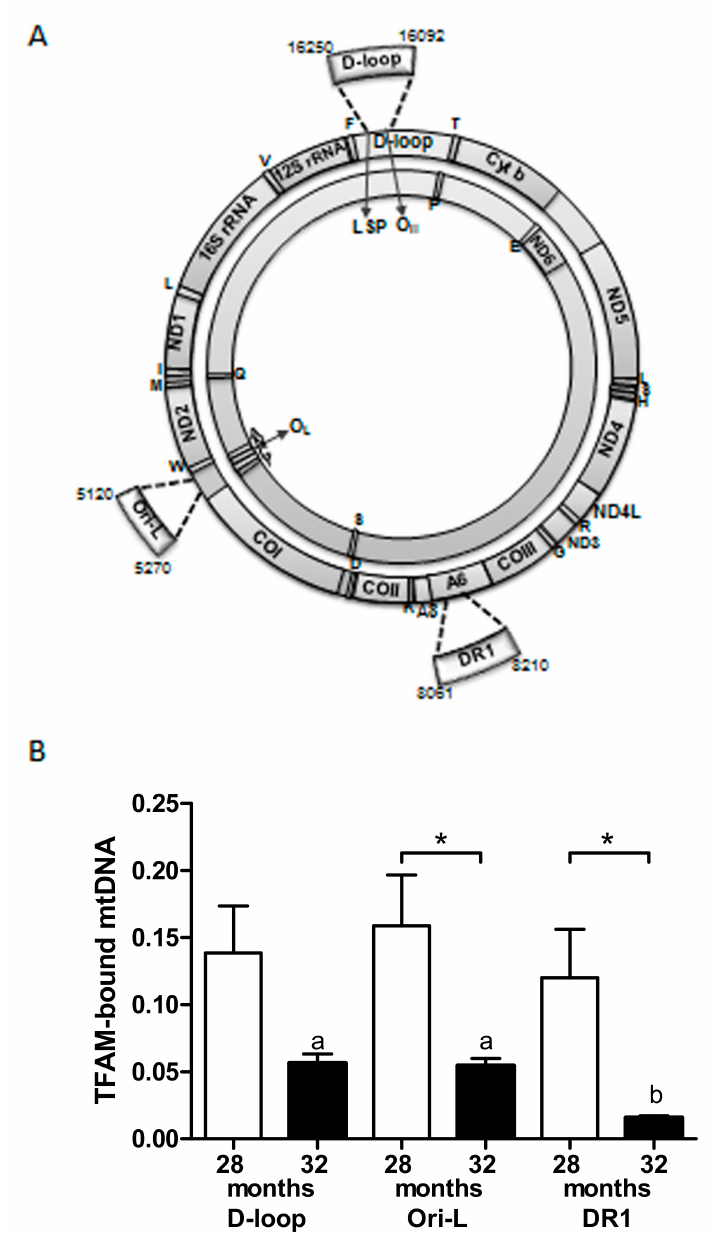
Figure 3. Localization and relative amount of TFAM-bound mtDNA at three mtDNA regions in liver from 28- and 32-month-old rats. ( A ) The amplified products enclose part of D-loop, Ori-L, and DR1-harboring regions, as depicted in the rat mtDNA map. ( B ) Bars represent the mean and SEM of the relative amounts of TFAM-bound mtDNA of two independent experiments performed in triplicate. Number of analyzed animals: 5 in the 28-month-old group, 4 in the 32-month-old group; * p < 0.05, Mann Whitney test. Bars not showing the same superscript di ff er significantly; p < 0.01, Dunn’s Multiple comparison test after Kruskal-Wallis